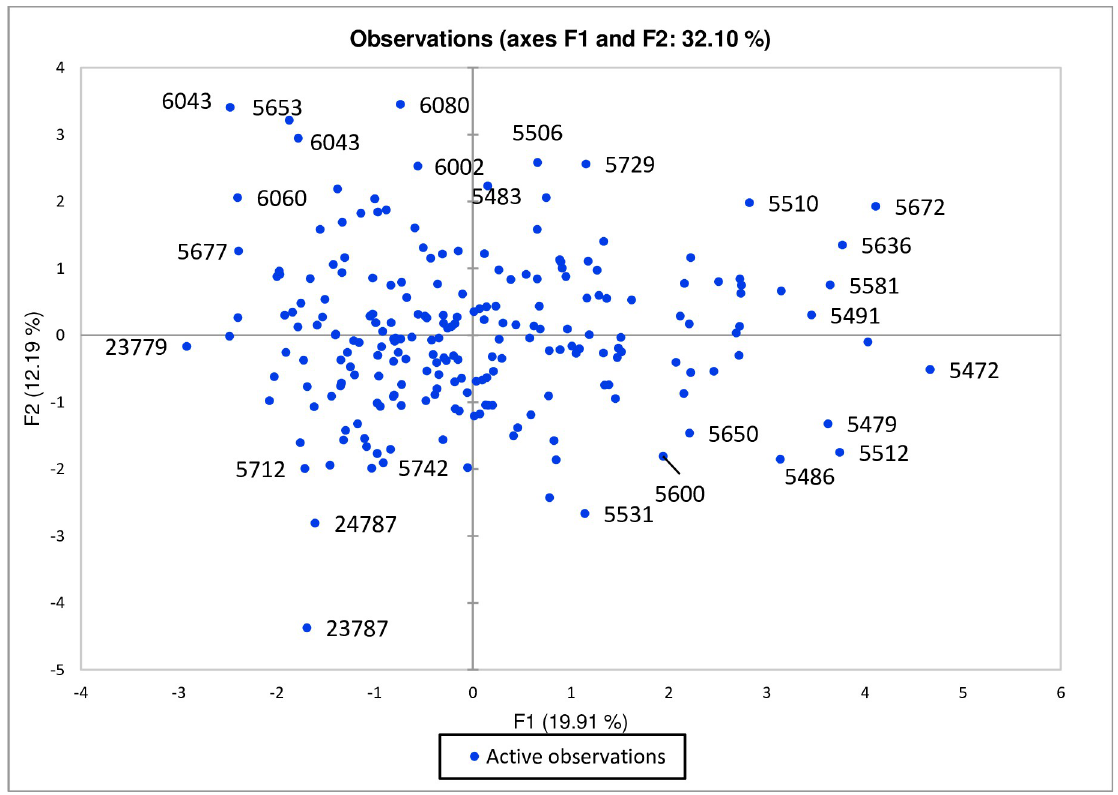
Fig 4. A scatter plot of PCA for lentil genotypes grown in